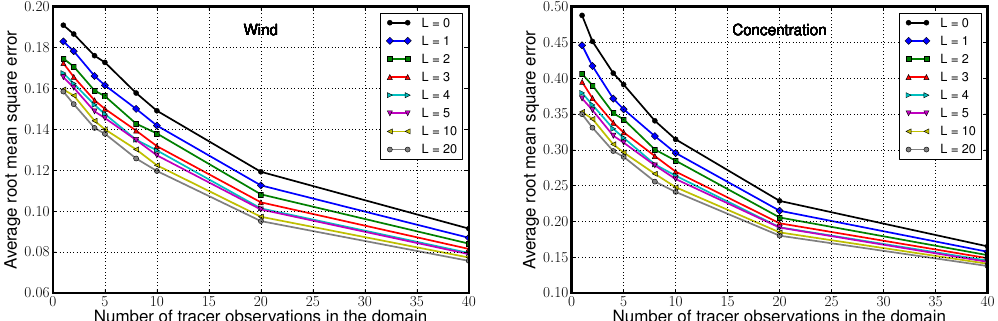
Figure 7. Average filtering analysis RMSEs of the wind variables (left) and concentration variables (right) of the L95-T, as a function of the number of concentration observations for the IEnKS with several DAW lengths. The case L = 0 corresponds to the ensemble transform EnKF.